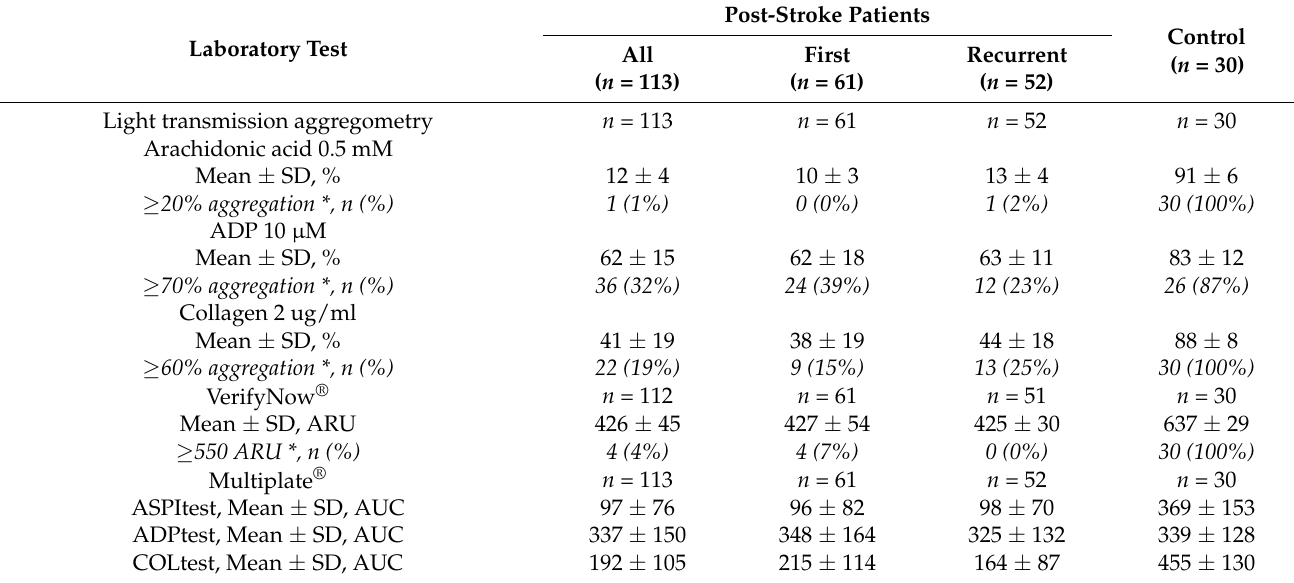
Table 2. Results of platelet function testing in the different